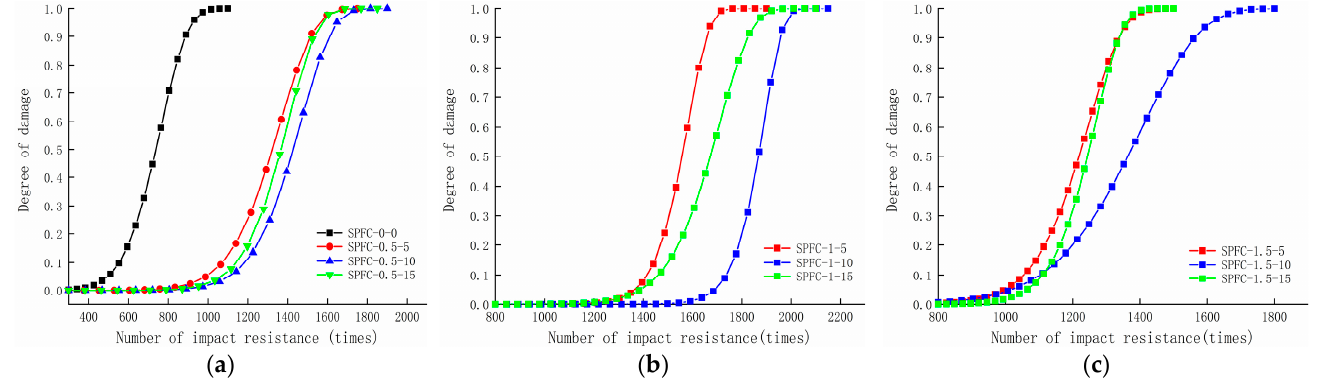
Figure 6. SPRC specimen impact-damage-evolution diagram ( a ) Impact-damage-evolution diagram of specimens with 0 and 0.5% polyvinyl alcohol fiber content; ( b ) Impact-damage-evolution diagram of specimens with 1% polyvinyl alcohol fiber content; ( c ) Impact-damage-evolution diagram of specimens with 1.5% polyvinyl alcohol fiber content.